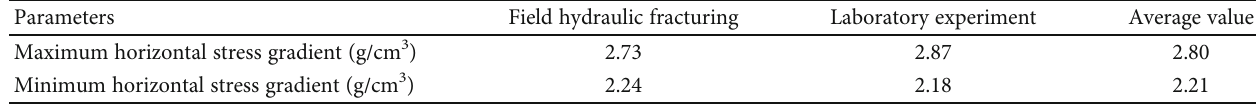
Table 1: The horizontal ground stress was determined by fi eld and laboratory experiments.